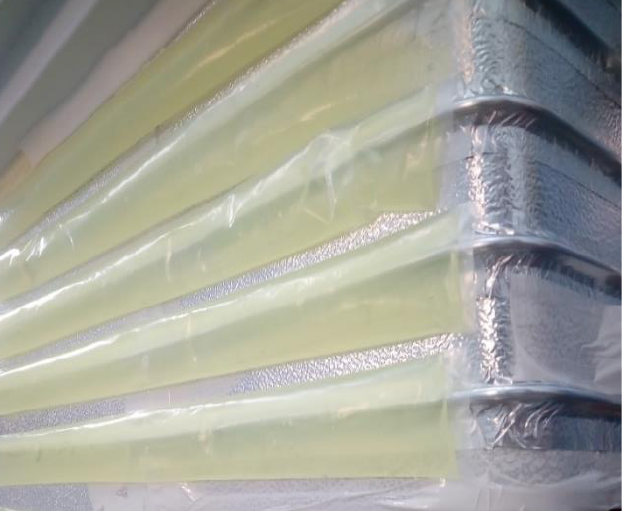
Figure 9. Application of a gelatinized eutectic PCM to the evaporator of a prototype chest freezer (photo courtesy: Vítor Silva, Tensai Indústria S.A., Portugal).